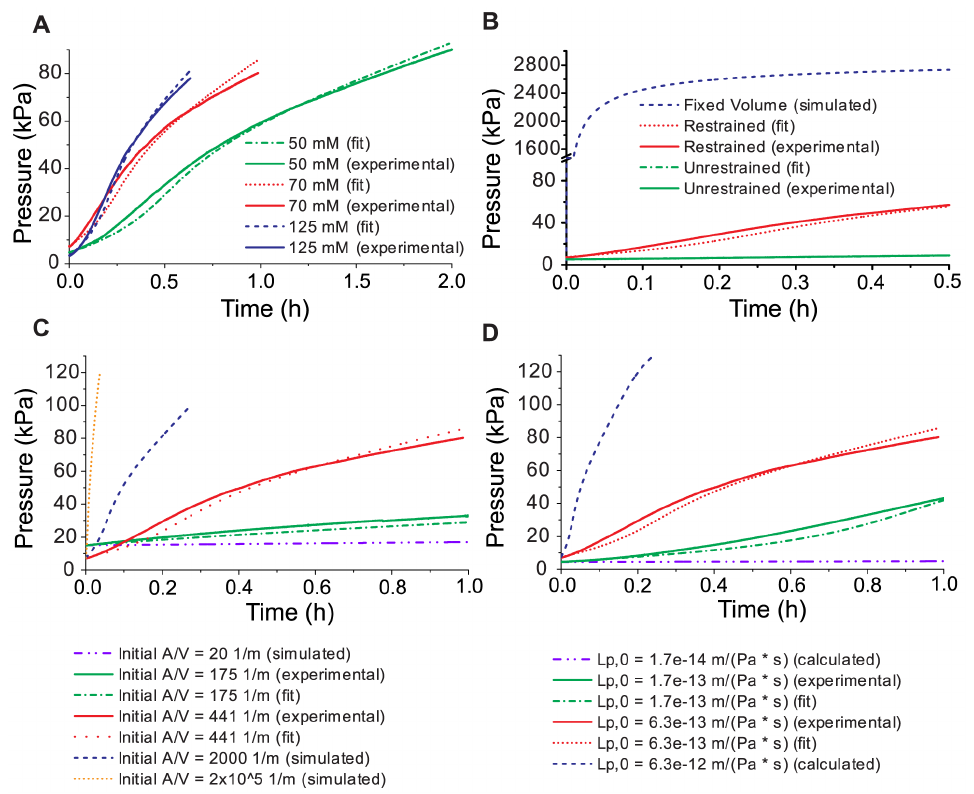
Figure 2. Dynamics of osmotically-driven pressure generation and comparison of the model based on Equation 4 with experimental data. A. Time-dependent pressure generation as a function of PEG-4000 concentration inside the dialysis cassette. B. Time- dependent pressure generation as a function of various mechanical constraints of the volume inside the dialysis cassette. C. Pressure generation dynamics as a function of various initial surface area to volume ratios. The dashed orange curve represents an initial A/V ratio taken from extensor cells of the plant Phaseolus coccineus .[24] D. Pressure generation dynamics as a function of various L p,0 values.